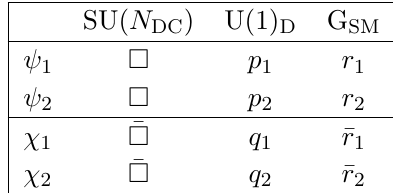
Table 1 . General structure of accidental axion models with n f = 2 . The possible charge assignments { p are restricted by the cancellation of gauge anomalies as discussed in the 1 , p 2 , q 1 , q 2 } main text. The group G is either the SM gauge group or one of its GUT extensions, and the SM possible representations r are classified in section i